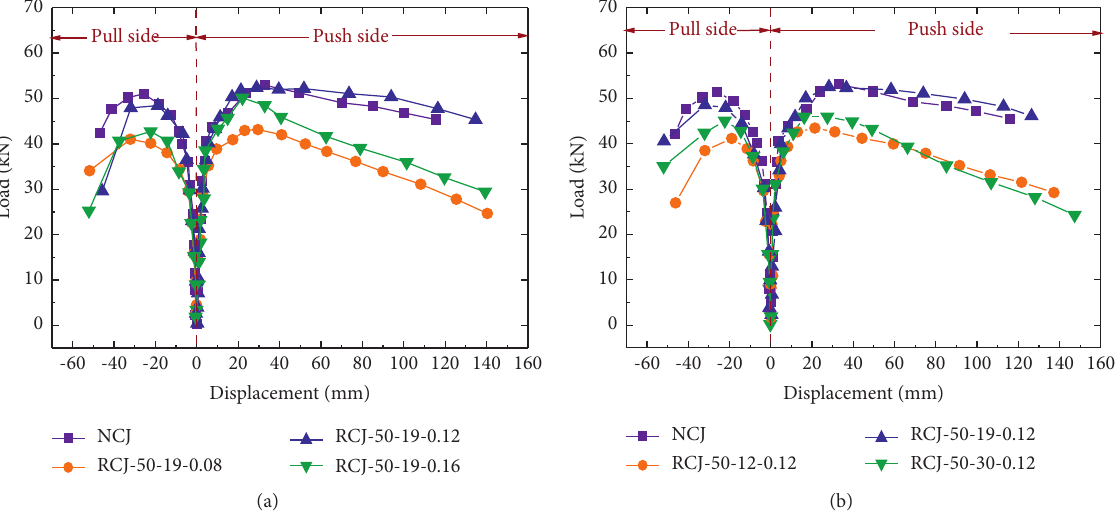
Figure 9: Load-displacement curves of waste fiber concrete specimens. (a) Volume of waste fibers. (b) Length of waste fibers.